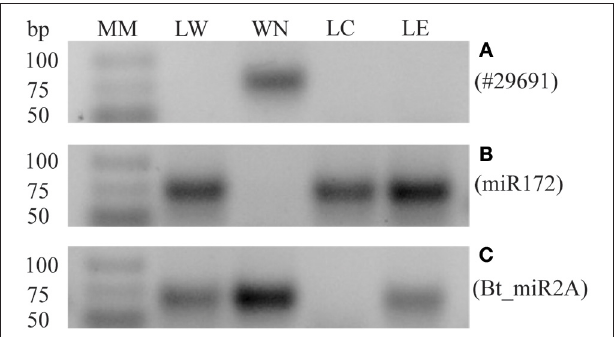
FIGURE 3 | Quality check of leaflet samples by stem-loop RT-PCRs. (A) Expression of nymph-specific sRNA #29691 in: leaflet first infested with whiteflies but with adults and nymphs subsequently removed (LW), whitefly nymphs (WN), control leaflet (LC), or leaflet with eggs (LE), showing a specific band in WN only. (B) Validation of the expression of tomato specific sRNA Sly_miR172 in the different samples. Expression is detected in LW, LC, and LE, but not in the WN sample. (C) Expression of the known whitefly-specific miRNA Bta_miR2A is also detected in LE. Similar results were obtained in